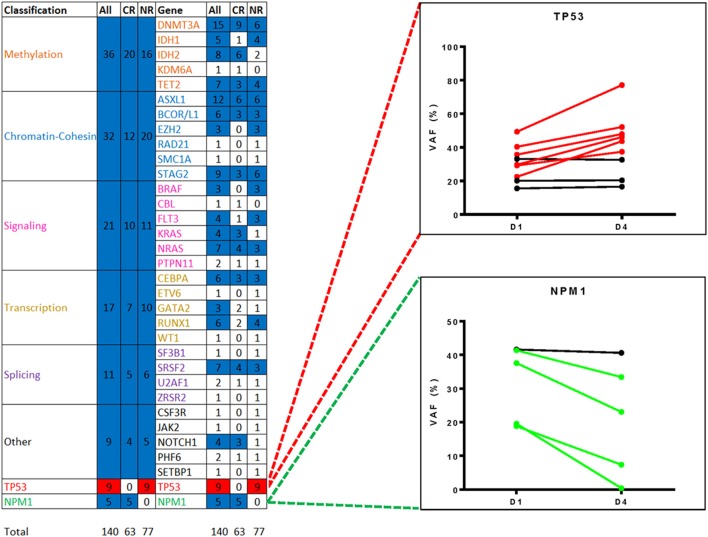
Changes in variant frequency during chemotherapy. All variants identified by targeted DNA sequencing in blood from day 1 of treatment (median VAF of 29%, range: 0.2–71%) were also detectable in blood from day 4 (median VAF 27%, range: 0.1–86%). Heatmap shows statistically significant changes in VAF between day 1 and 4 by either gene functional class or by individual gene/gene region, for all patients or just those with complete remission (CR) or non-responder (NR). Variants were only counted once per gene region per patients. Mutated TP53, detected only in NR patients, was significantly different (red, P < 0.05) and mutated NPM1, detected only in CR patients, demonstrated a consistent trend (blue, P = 0.0625). The remaining functional groups and individual genes were either non-significant (blue) or had too few data points for analysis (white). VAF, variant allele frequency.